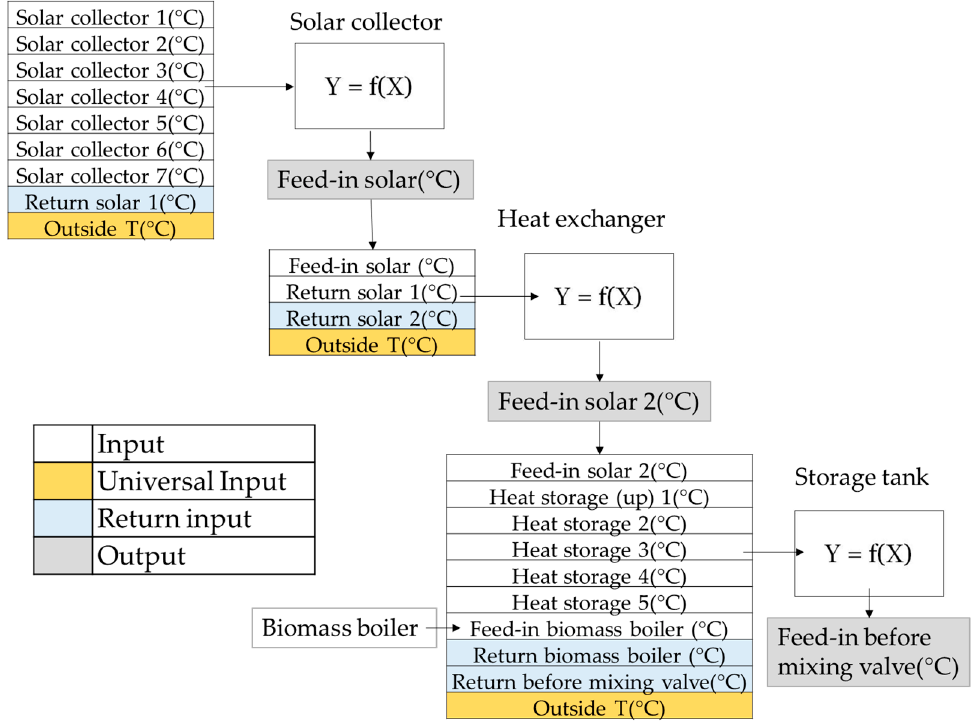
Figure 1. Detailed representation of the interconnection of the different components of the system, along with the respective inputs and outputs.